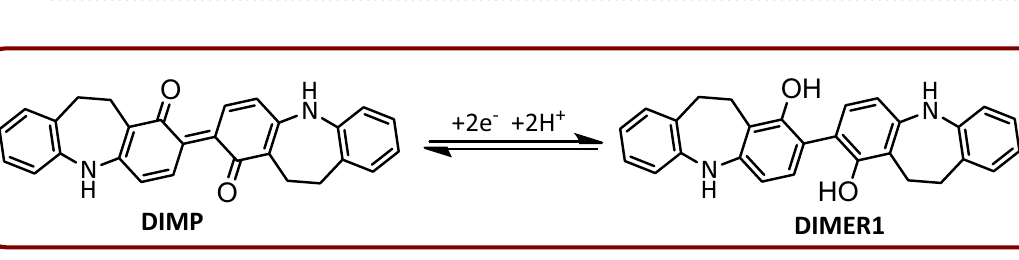
Figure 7. The redox behavior of A 0 /C 0